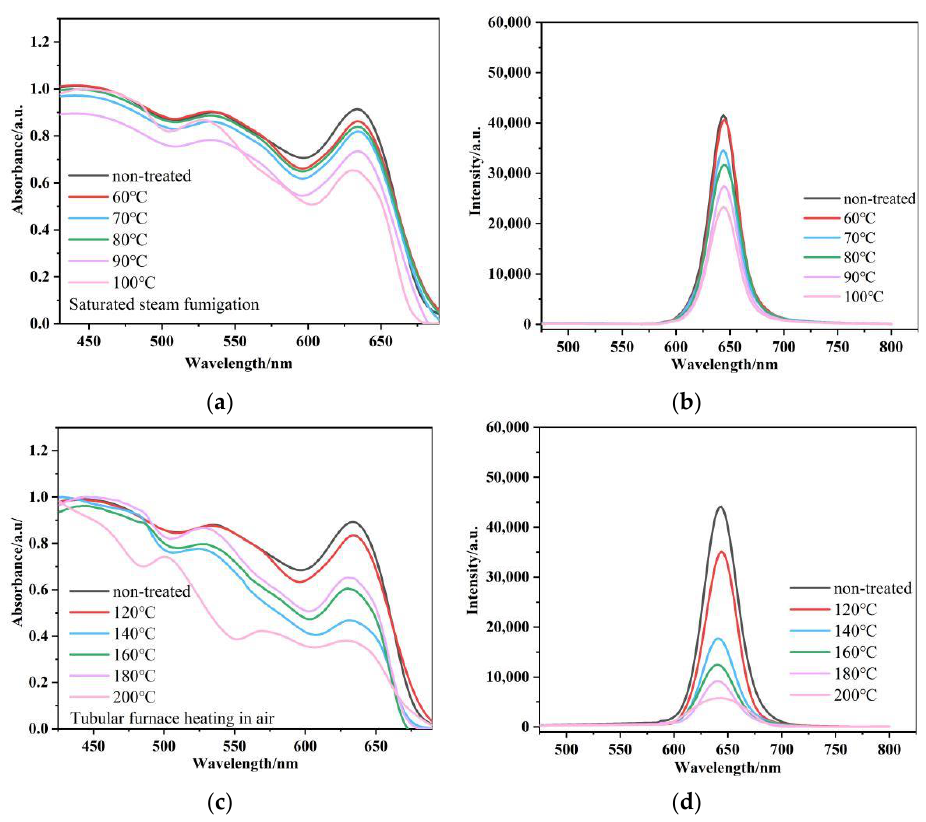
Figure 8. Absorption and photoluminescence spectra of CdSe@Poly(S-MMA) hybrid fibers under different conditions for 30 min; ( a and b ) steaming fumigation at different temperatures; ( c and d ) dry heating at different temperatures. λ exc = 450 nm.